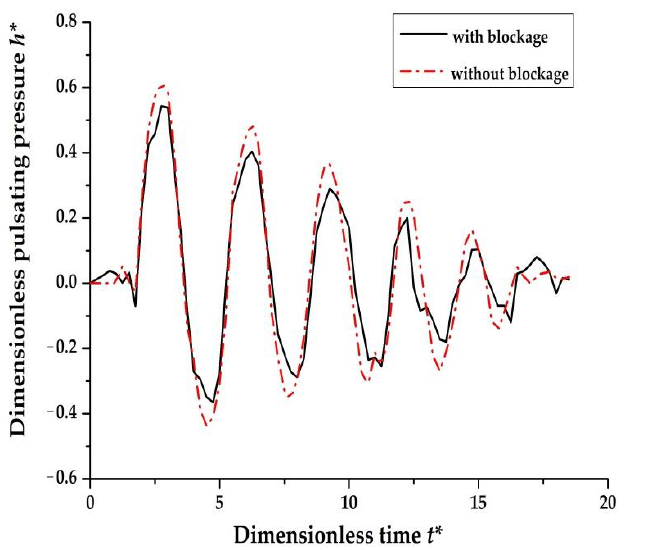
Figure 8. Dimensionless fluctuating pressures with dimensionless time with and without blockages. By using Fourier series analysis, the dimensionless fluctuating pressure curves with and without blockages were decomposed into different period forms, and the amplitudes of each individual harmonic in different periods were obtained, as shown in Figure 9.